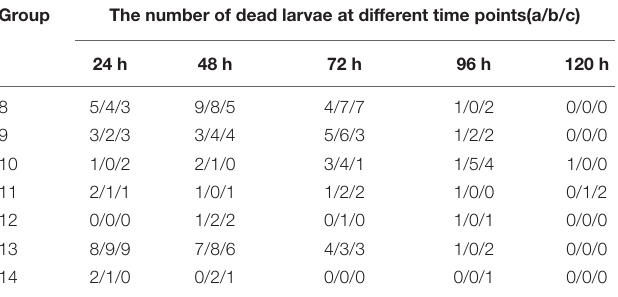
TABLE 2 | The curative effect on CSBV of using the specific IgY. Group